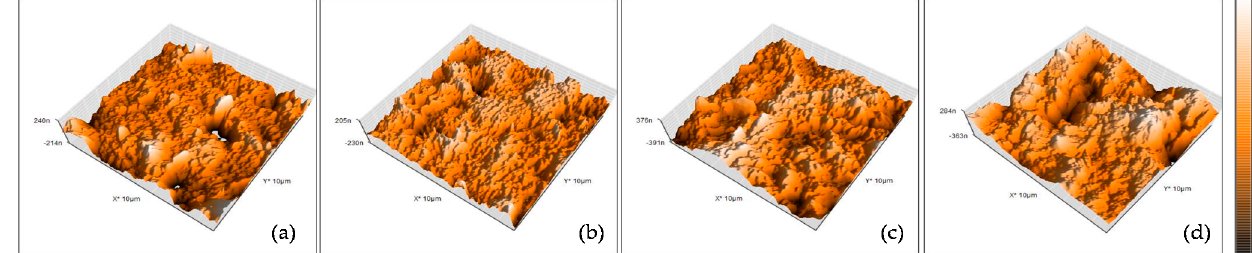
Figure 7. AFM image of the ( a ) virgin membrane, ( b ) fouled membrane in period I, ( c ) fouled membrane in period II, and ( d ) fouled membrane in period III.